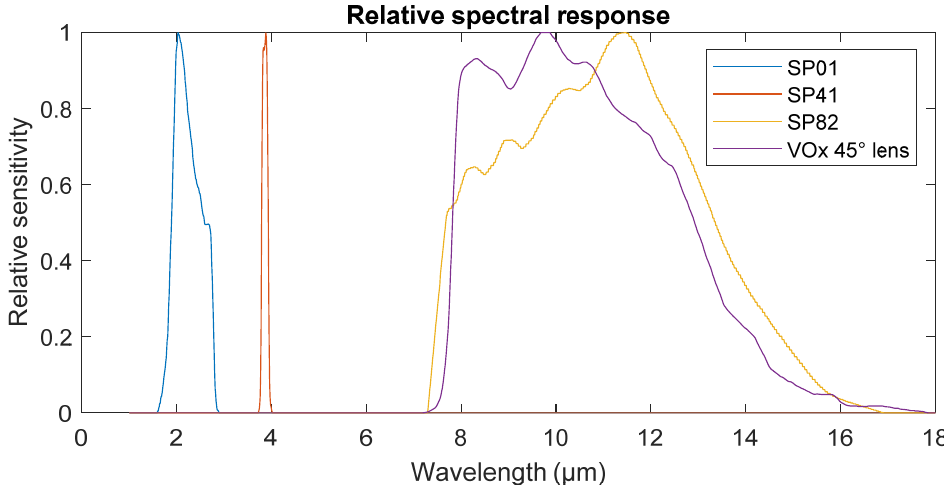
Figure 5. Relative spectral sensitivity of sensors.